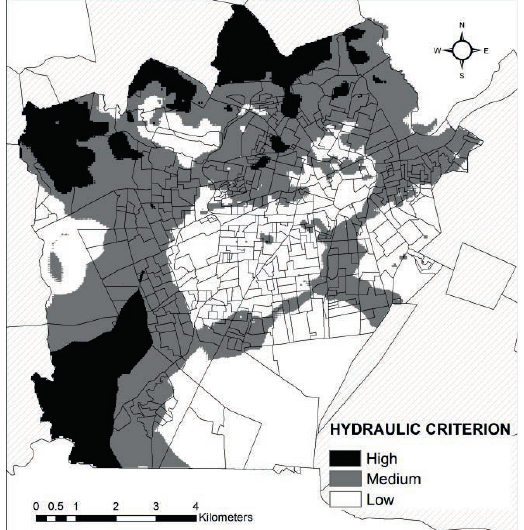
Fig. 3 Supply risk based on hydraulic criterion.